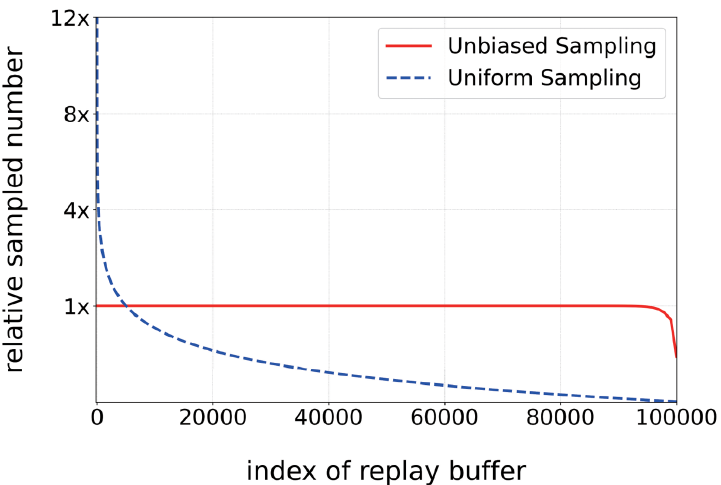
Fig 3. The sampling-efficacy following by two methods. By extracting twice the amount and sorting them, all elements are used equally for learning. Unbiased Sampling prevents unwise early records from being leveraged much more than rich